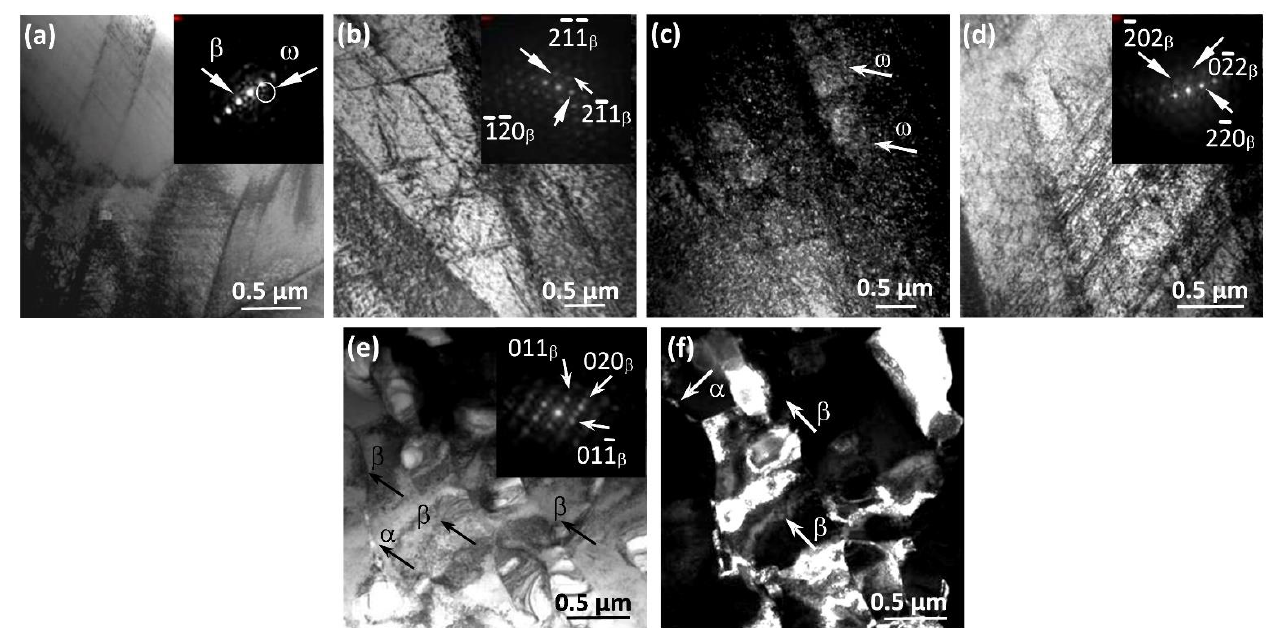
Figure 10. Microstructure of the Ti-45Nb alloy in the CG state before fracture in the neck area: ( a , b , d , e ) — the BF TEM images with the SAD patterns; ( c , f ) — the DF TEM images taken in reflections of ω - and β -phases. Band fragments ( a – c ) with a cellular-network dislocation substructure ( d ), fragmented substructure ( e , f ). Arrows show reflections from identified phases and phases.